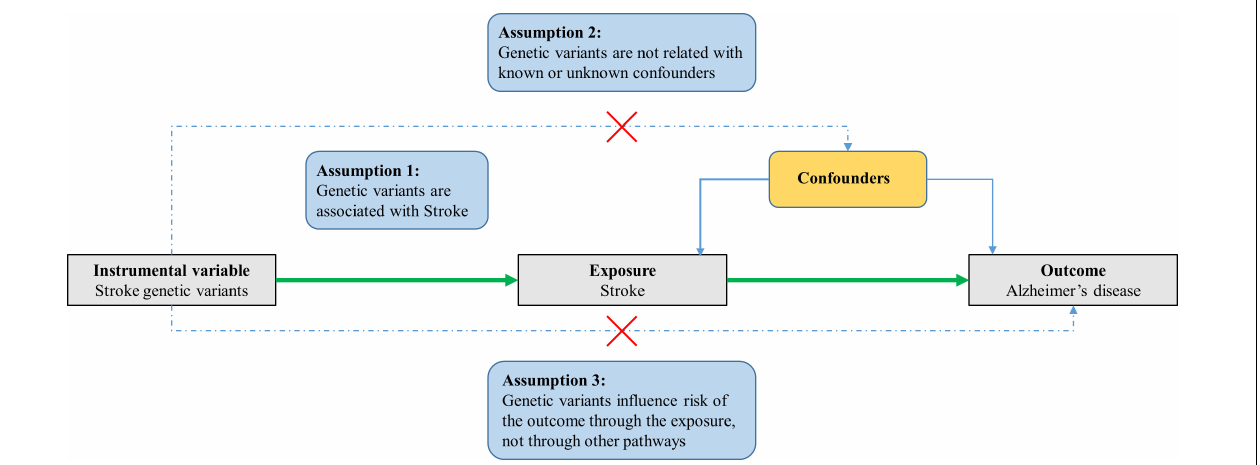
FIGURE 1 | Three assumptions for MR analysis. Firstly, the genetic variants, which are selected as the instrumental variables, are associated with the exposure (stroke). Secondly, genetic variants are not related to known or unknown confounder factors. Thirdly, genetic variants would have an influence on the outcome (AD) only through exposure (stroke), not through other